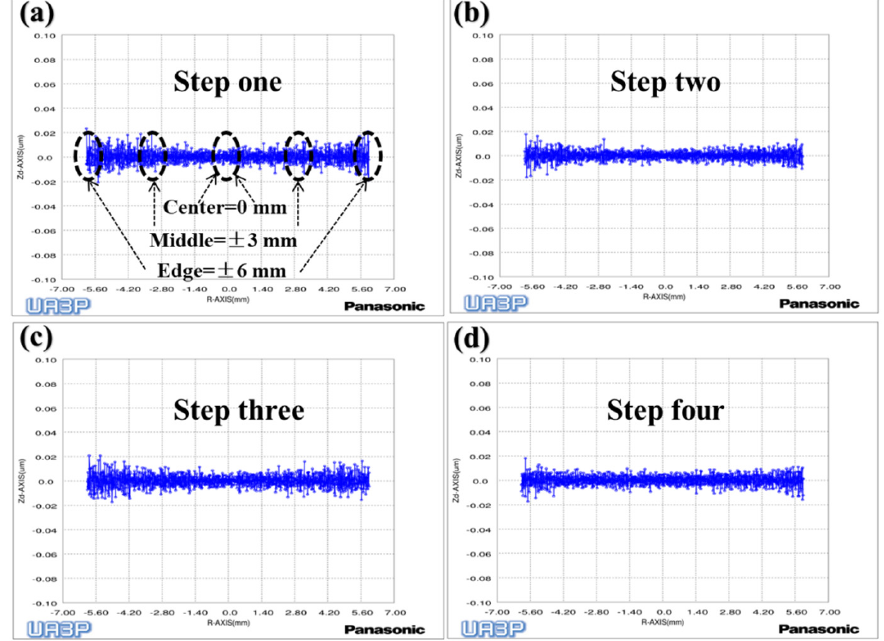
Figure 18. Process of SR distribution change of aspherical mold two: ( a ) Grinding ( b ) Polishing with small polishing disc tool; ( c ) Polishing with constant rotation speed mode; ( d ) Polishing with variable speed mode.